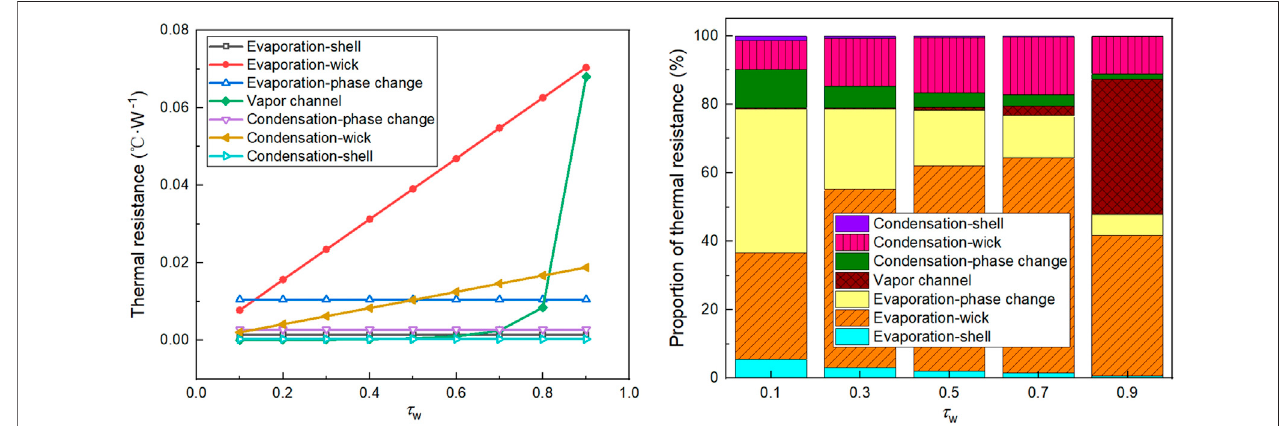
FIGURE 10 | (A) Thermal resistance of each unit at different τ w. (B) Proportion of different thermal resistances at different τ w.